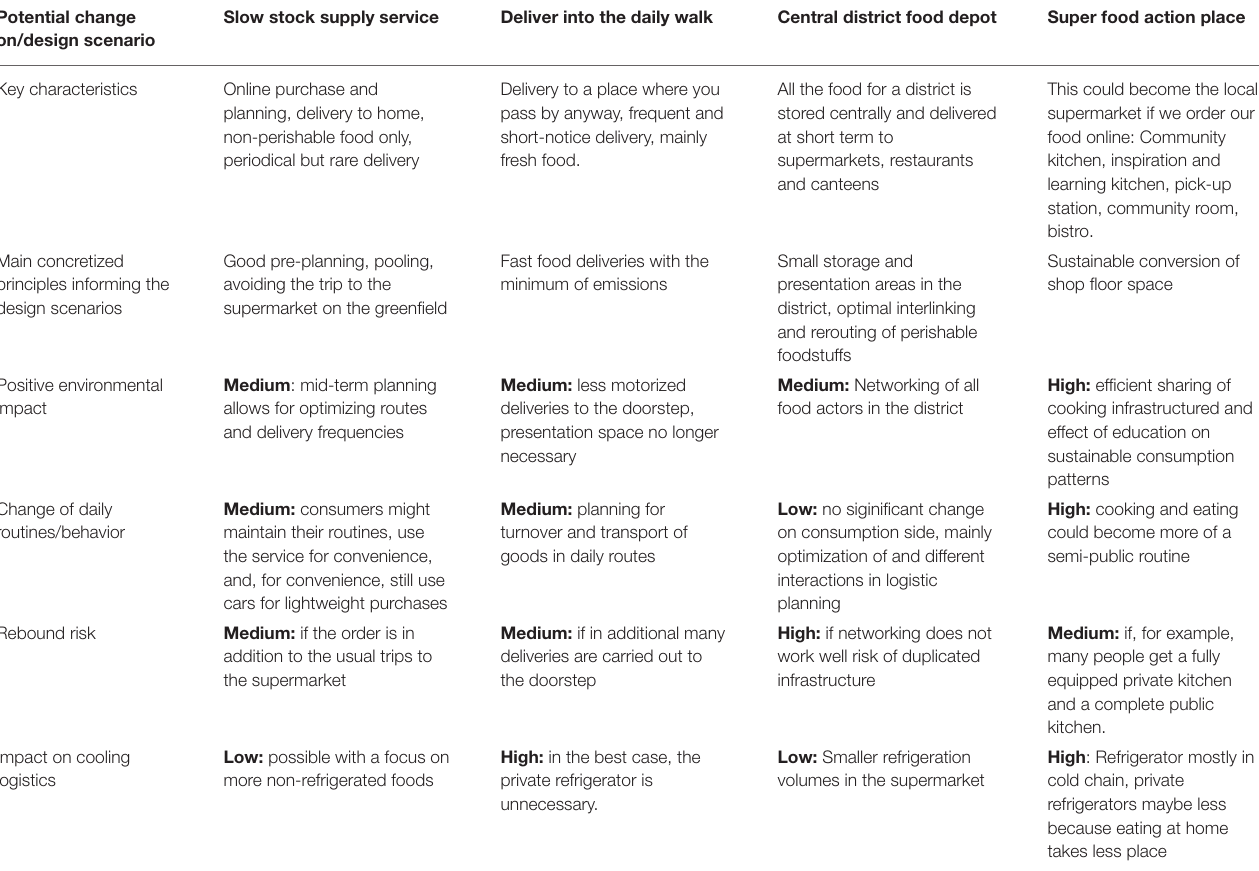
TABLE 2 | Overview and assessment of design scenarios. Potential change on/design